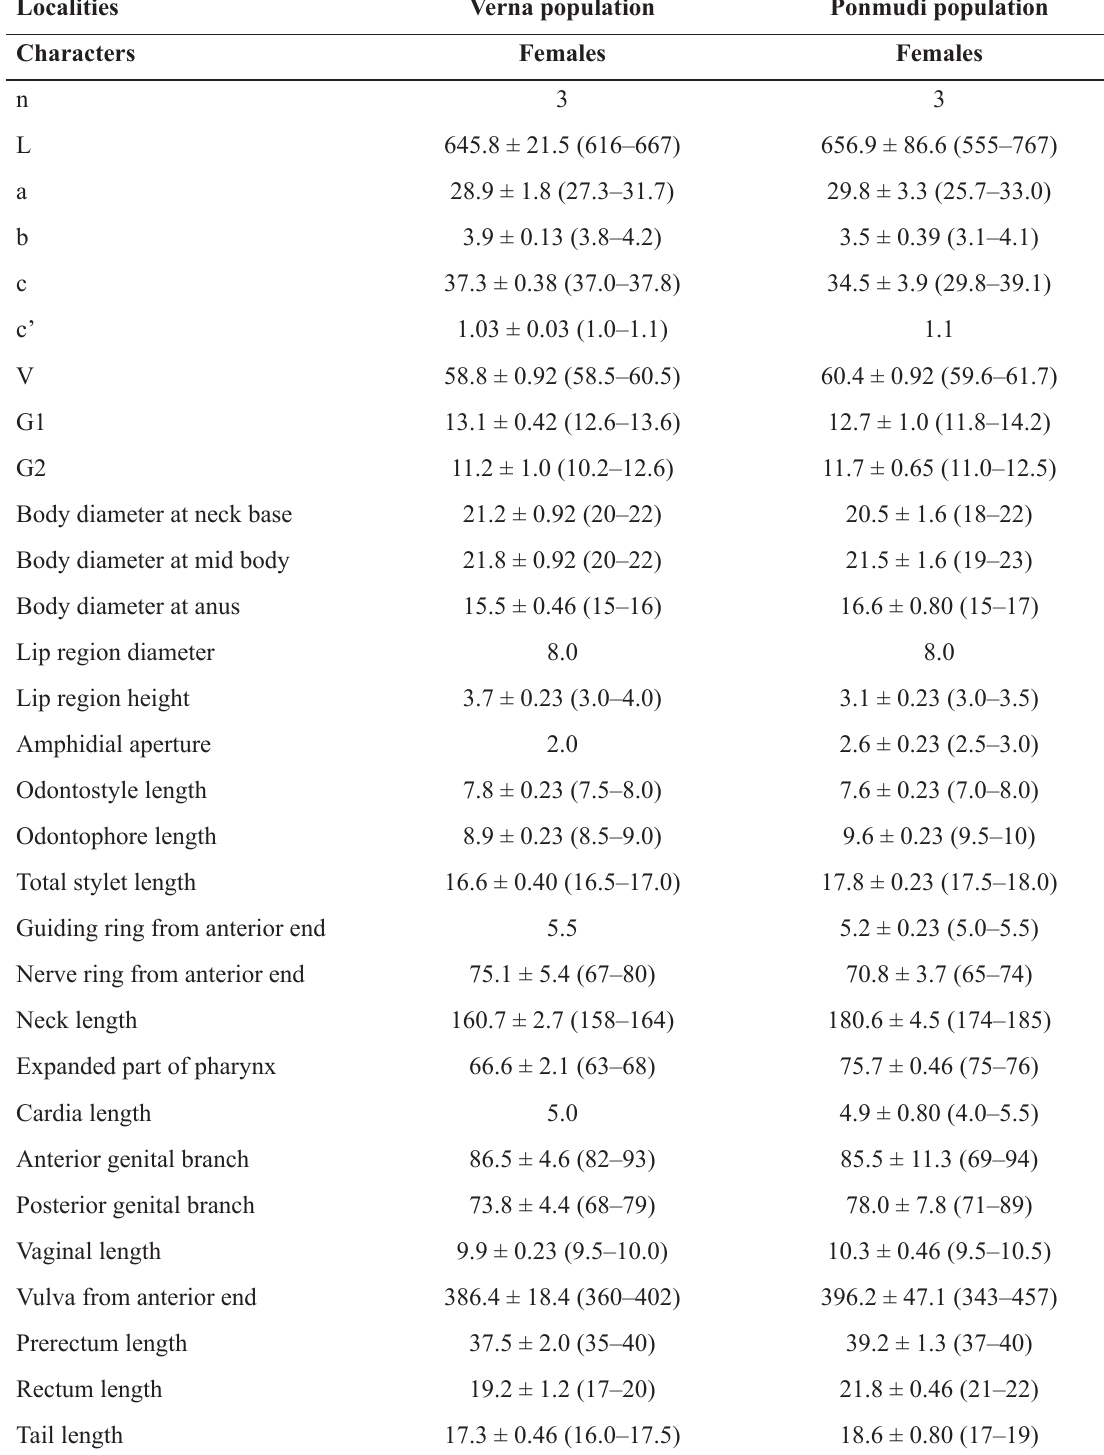
Table 5. Measurements of Tylencholaimus cosmos (Dhanam & Jairajpuri, 1999). All measurements are in µm and in the form: mean ± s.d.